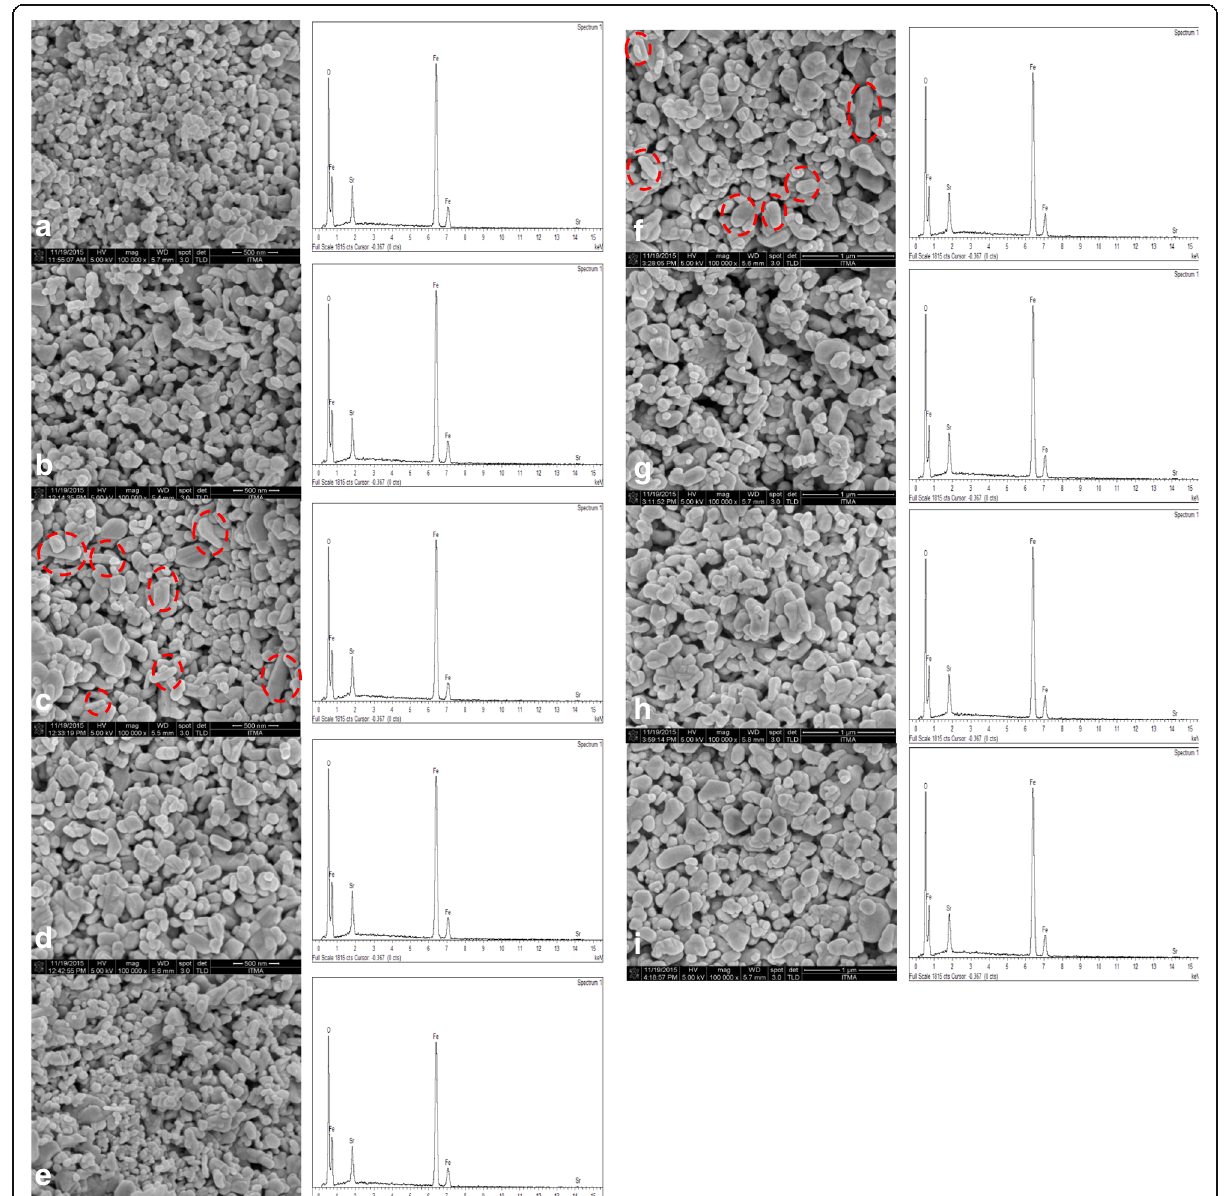
Fig. 6 The FESEM micrographs of samples sintered at 900 °C by varying pH: a pH 0, b pH 1, c pH 2, d pH 3, e pH 4, f pH 5, g pH 6, h pH 7, and i pH